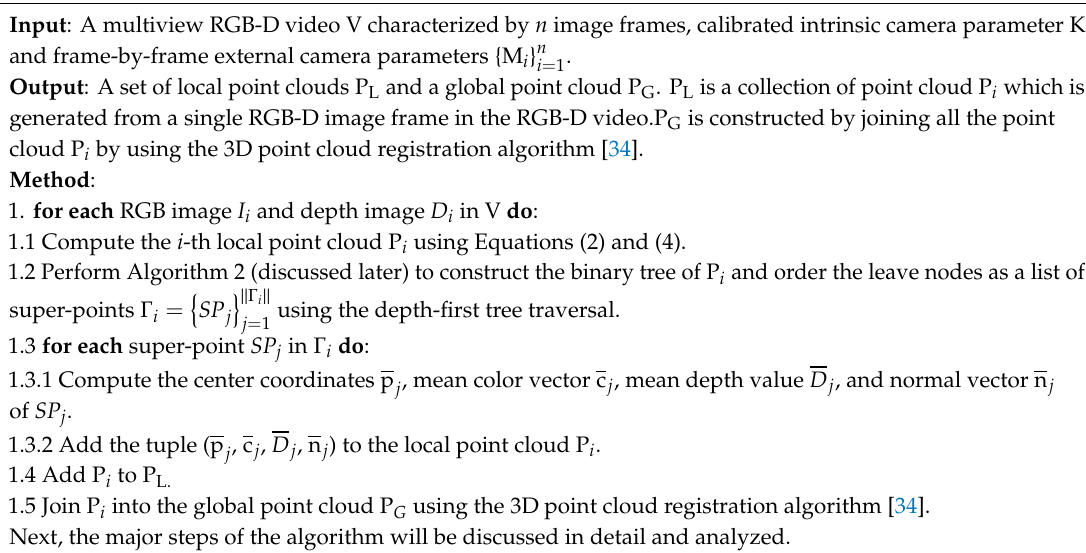
Algorithm 1. Generation of 3D Scene Point